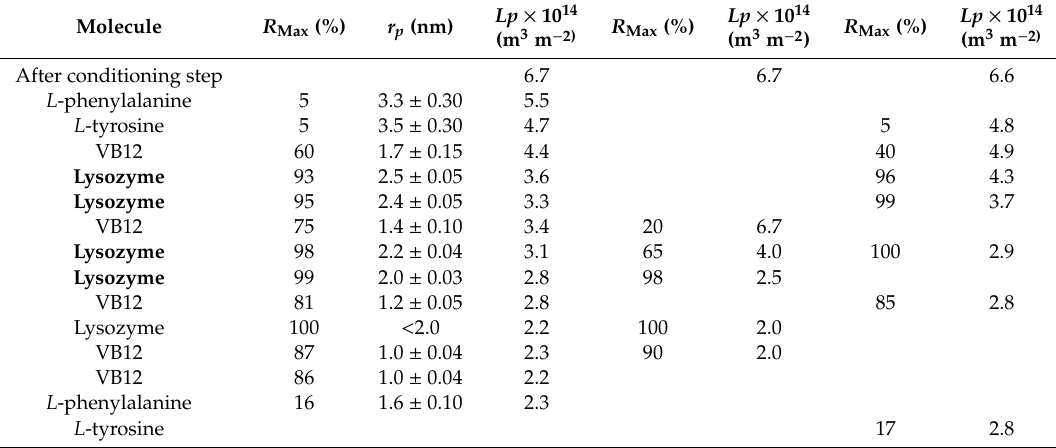
Table 2. Filtration experiments (chronologic order) for the three series of tests.